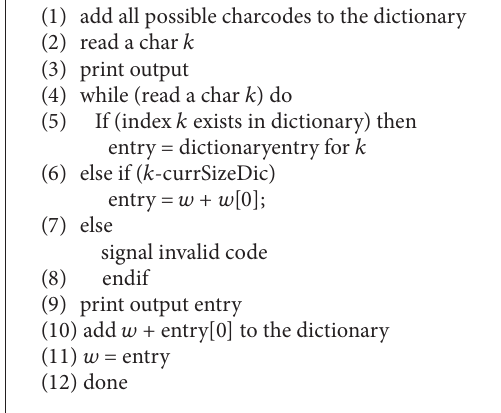
Table 2: Benchmark datasets and their